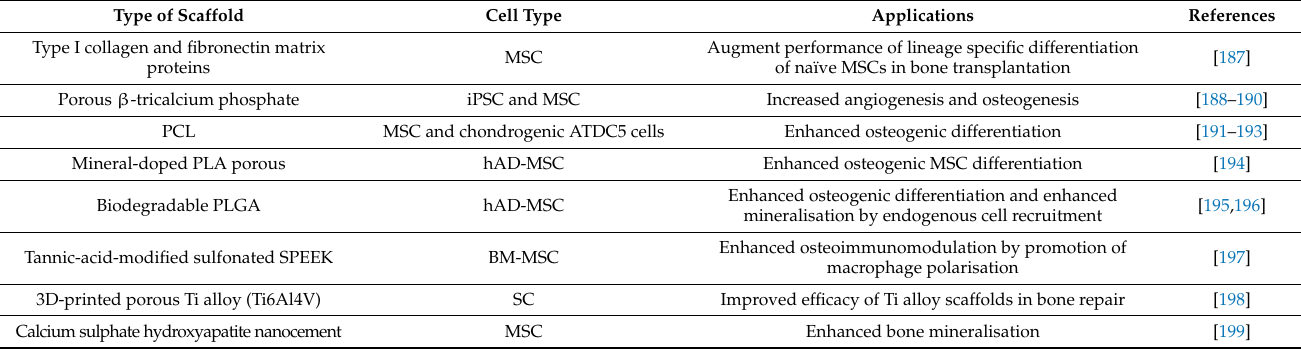
Table 4. Scaffold–exosome approaches for bone